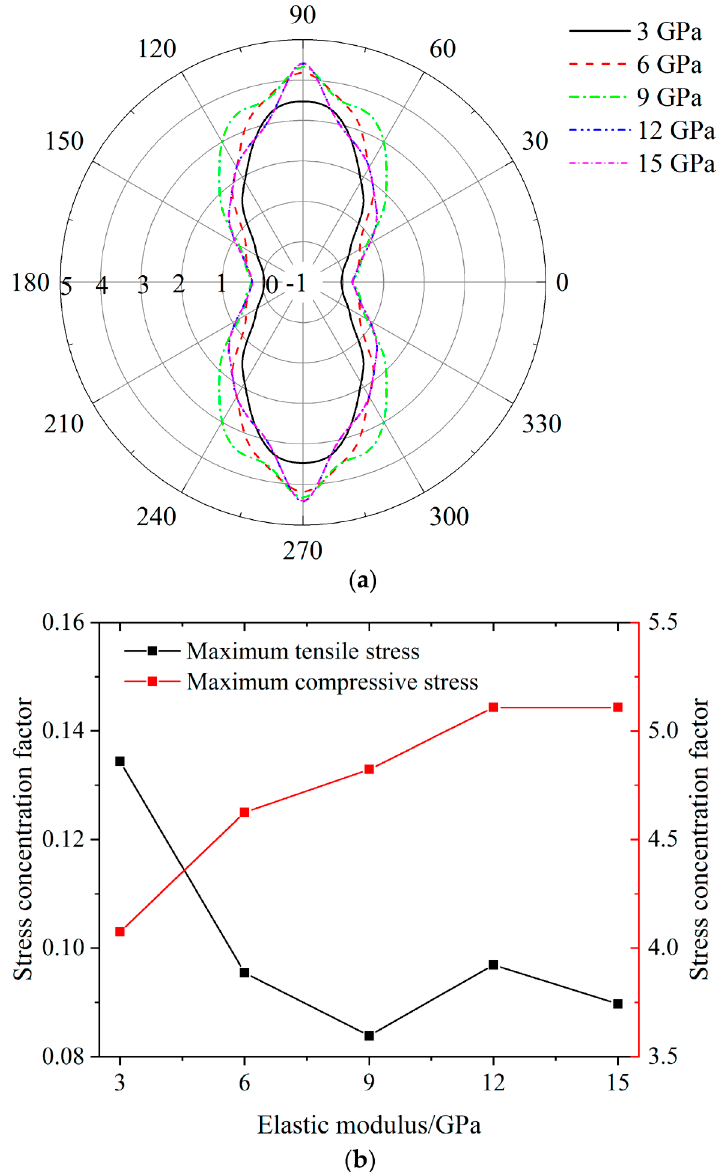
Figure 24. Variation in stress concentration factor with respect to elastic modulus. ( a ) DSCF around hole under elastic modulus, ( b ) maximum stress concentration factor with respect to elastic